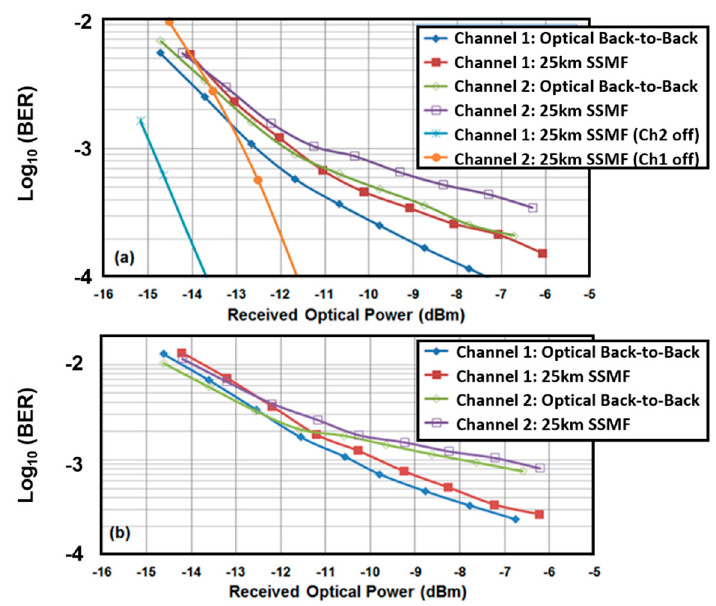
Figure 6. BER vs. received optical power. ( a ) Identical modulation of 16-QAM on all subcarriers of each channel. ( b ) Adaptive subcarrier bit loading applied on each channel. (Channel 1: In-phase, Channel 2: Quadrature).